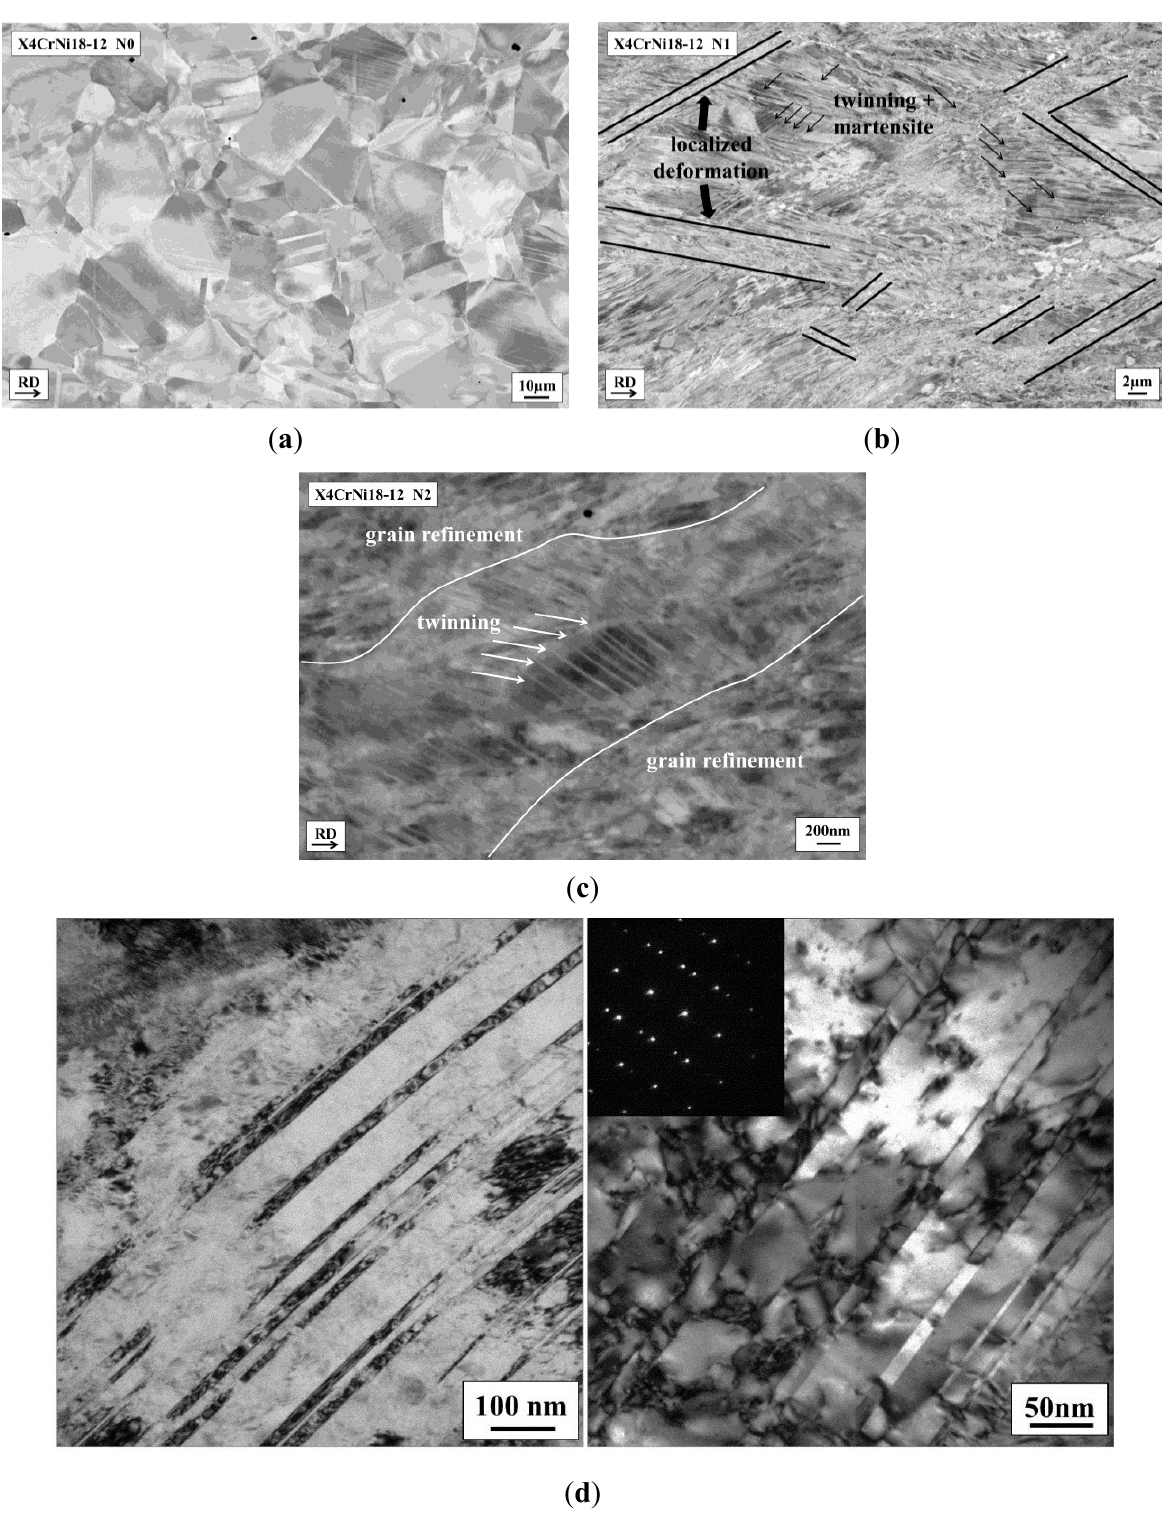
Figure 4. SEM micrographs of ARB-processed austenitic steel X4CrNi18-12 after ( a ) N0, ( b ) N1 and ( c ) N2. The arrows indicate areas where twins but also martensite were found. In ( d ) TEM captions of a highly twinned region with the corresponding diffraction pattern is shown after N2 cycles of